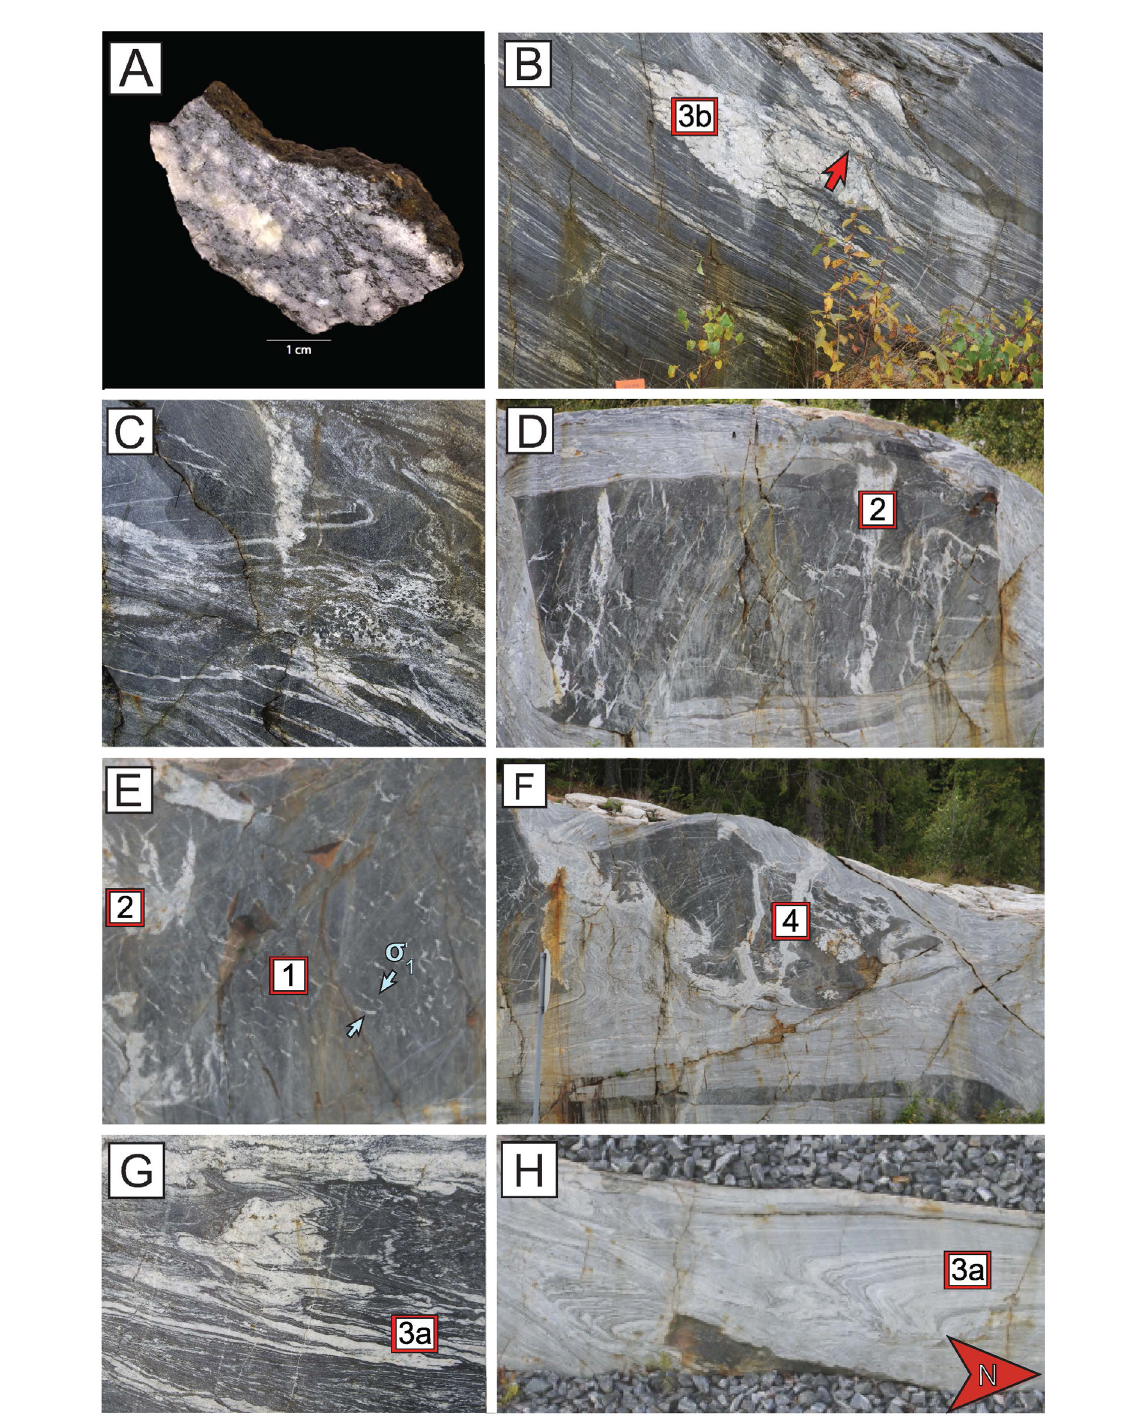
Figure 4. Critical elements of the shear zone. The labels 1, 2, 3a, 3b and 4 indicate the pegmatite types. The N-arrow at the bottom applies to all the individual figures (A) Country rock: migmatitic biotite gneiss. (B) Irregular, sheared Type 3b-pegmatite accumulated in fold closure. Note a shear zone that transects pegmatite body (red arrow) demonstrating that the Type 3b-pegmatites intruded before the last stage the of shear zone development. (C) A strongly migmatitic domain of garnet amphibolite with various neosome varieties, including amphibole bearing leucosome, locally folded and crossed by pegmatite. (D, F) Relation between garnet amphibolite boudins and various generations of pegmatites. (E) Type 1 pegmatite in garnet amphibolite boudin. Note preferred orientation of pegmatitic veinlets indicating that σ (blue arrows) was oriented with a dip-angle of c. 30 o towards the north relative to the present vertical during pegmatite formation. The shear foliation in the granodioritic biotite gneiss country rock also dips c. 30 o towards the present north. Also note that a Type 2-pegmatite intrusion transects the Type 1. (G) Zone in the biotite gneiss with disharmonic folds that includes Type 3a-pegmatite pods. Note that Type 3a-pegmatite pods occur with contrasting geometries and shear intensity, suggesting a syn-tectonic development. (H) Relations between overturned top-south tight to isoclinal fold, main foliation and Type 3a